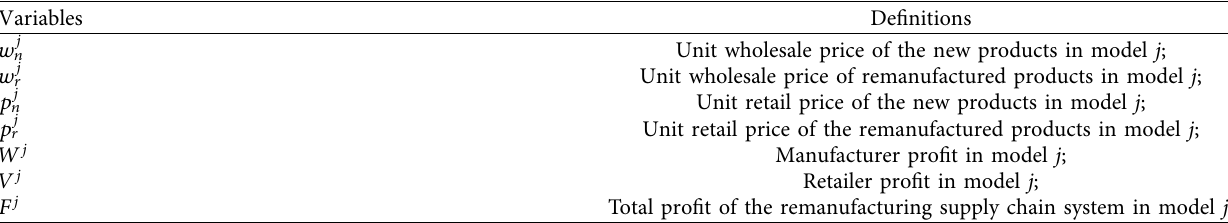
Table 3: Variables (including objective